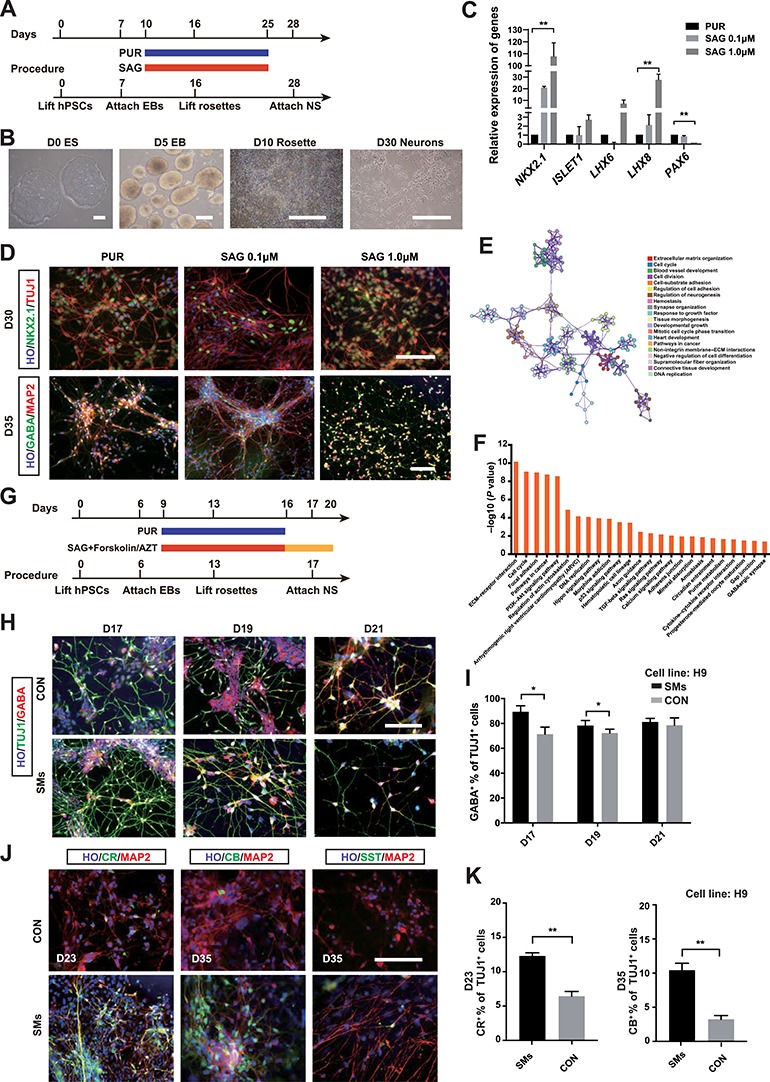
Optimization of conditions for accelerating the generation of GINs from hPSCs. (A) Timeline of GIN generation. (B) Illustration of differentiation of GINs from hPSCs. Scale bar, 100 μm. (C) Fold change of mRNA expression levels in different groups of H9 cells at Day 17. The data are presented as mean ± SEM. n = 3; **P < 0.01. (D) Representative images of NKX2.1 and TUJ1 immunostaining. Scale bar, 100 μm. (E) Network of enriched GO terms, colored by cluster ID, where nodes that share the same cluster ID are typically close to each other. (F) KEGG pathway analysis of upregulated and downregulated genes in the SMs group. (G) Schematic diagram showing the timing of administration of SAG, Forskolin, and AZT during the differentiation. (H) Immunostaining for GABA+ neurons, expressing GABA (red) among the neurons (TUJ1), from D17 to D21. Scale bar, 100 μm. Cell line, H9. (I) Percentage of the total cells expressing GABA during the differentiation. More than 5000 cells from random fields were manually counted in each condition. The data are presented as mean ± SEM. n = 3; *P < 0.05. (J) Immunostaining for GIN subtype markers CR, CB, and SST in H9 cells. Scale bar, 100 μm. (K) Percentage of the total cells expressing CR and CB during the differentiation. More than 1500 cells from random fields were manually counted in each condition. The data are presented as mean ± SEM. n = 3; **P < 0.01.